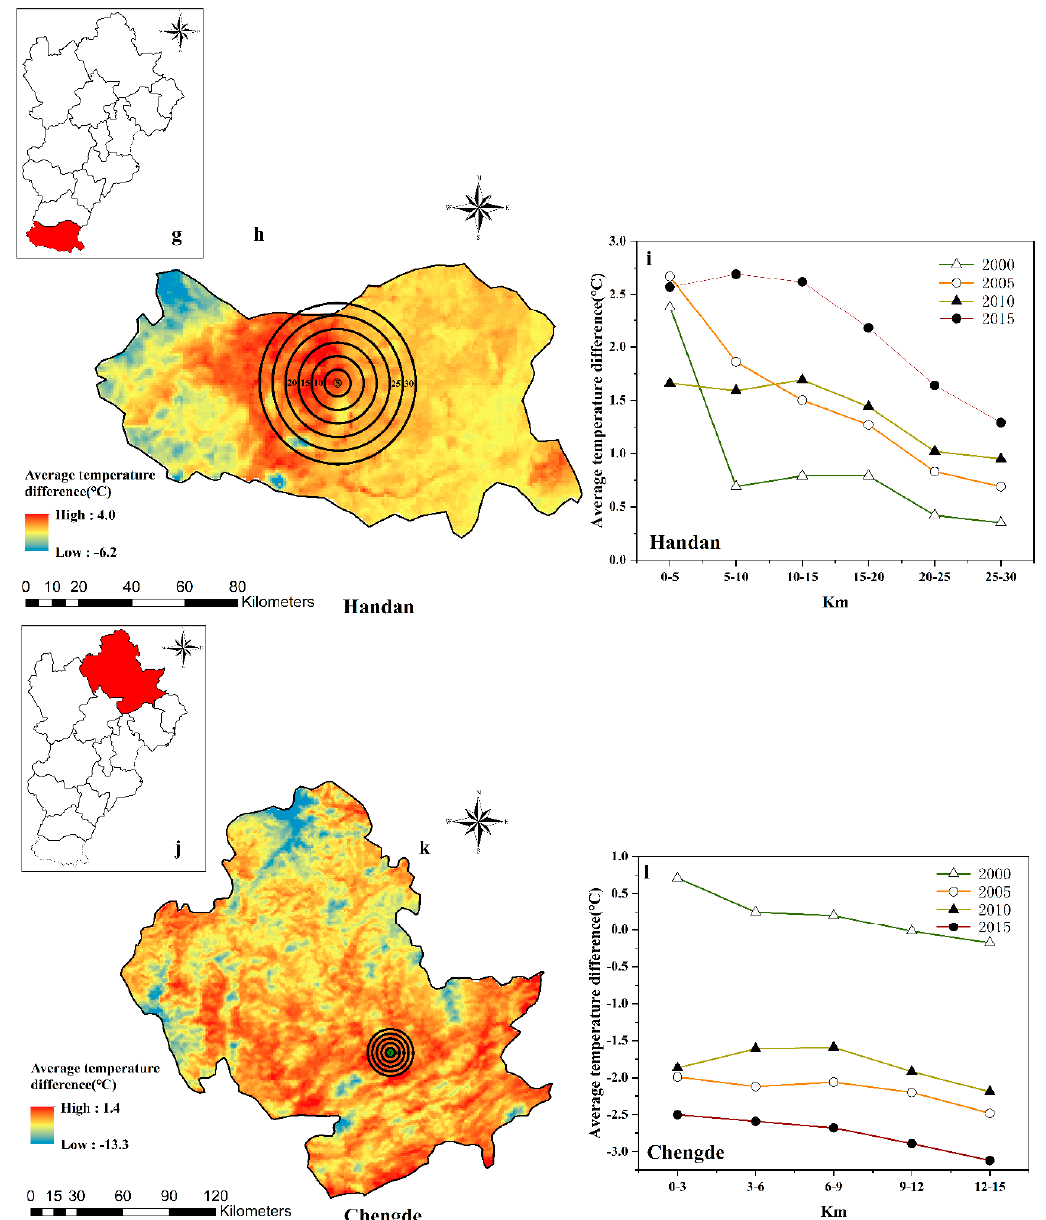
Figure 5. Temperature differences of different circles of typical cites. ( a,d,g,j ) Location of typical cities. ( b,e,h,k ) The average temperature difference and range and numbers of circles in Beijing, Tianjin, Handan, and Chengde, respectively. ( c,f,i,l ) The average temperature difference of each circle in the four cities in 2000, 2005, 2010, and 2015.